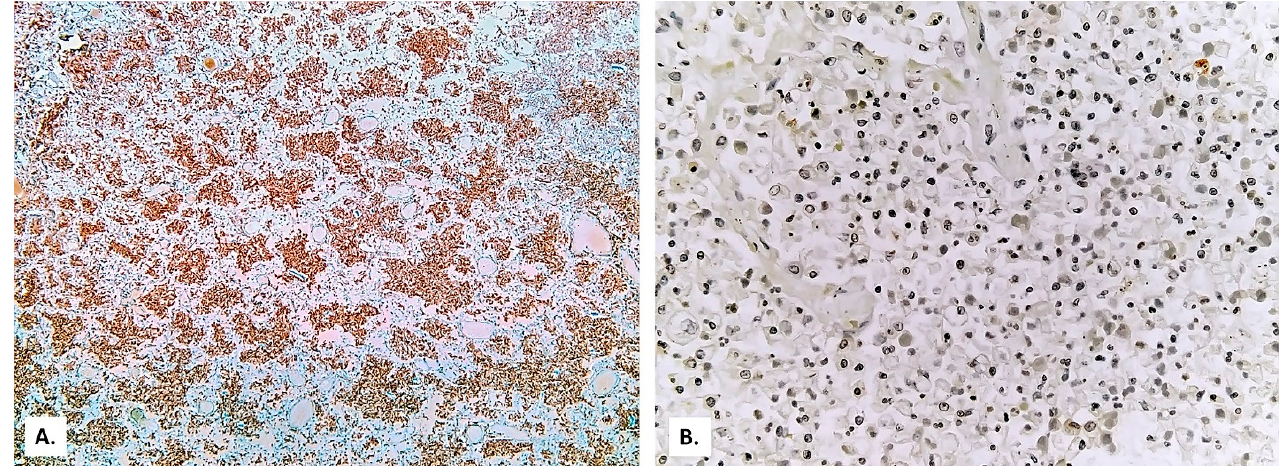
phages also reaches the bronchial lumen which shows desquamated epithelium (arrows) (HE × 100).